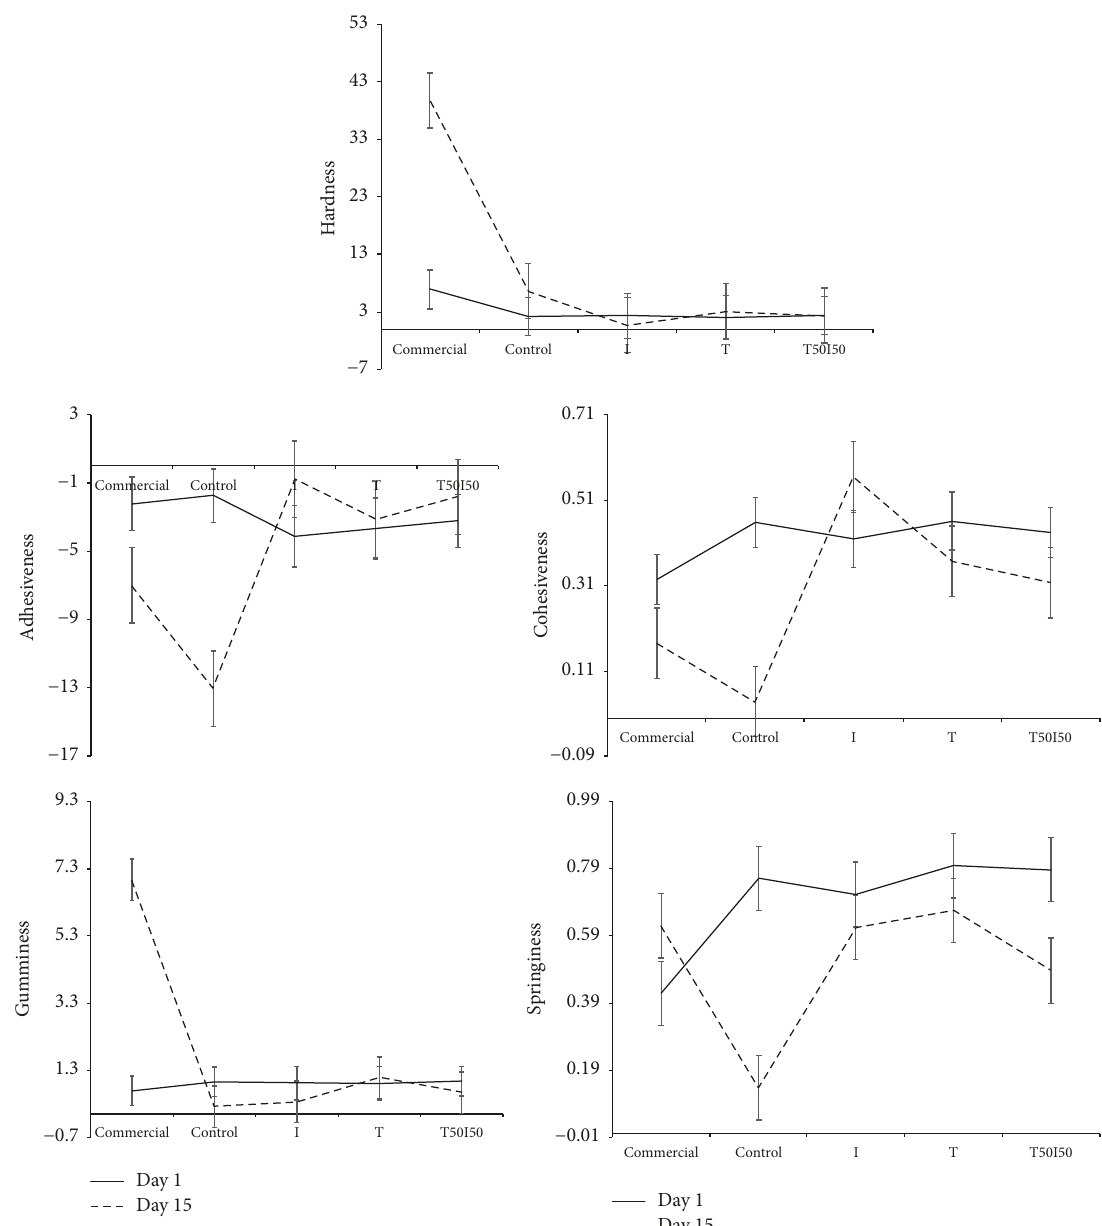
Figure 2: Interaction graphics ( 𝛼 = 95%) of hardness, adhesiveness, cohesiveness, gumminess, and springiness of watermelon jelly as a function of the formulation and storage